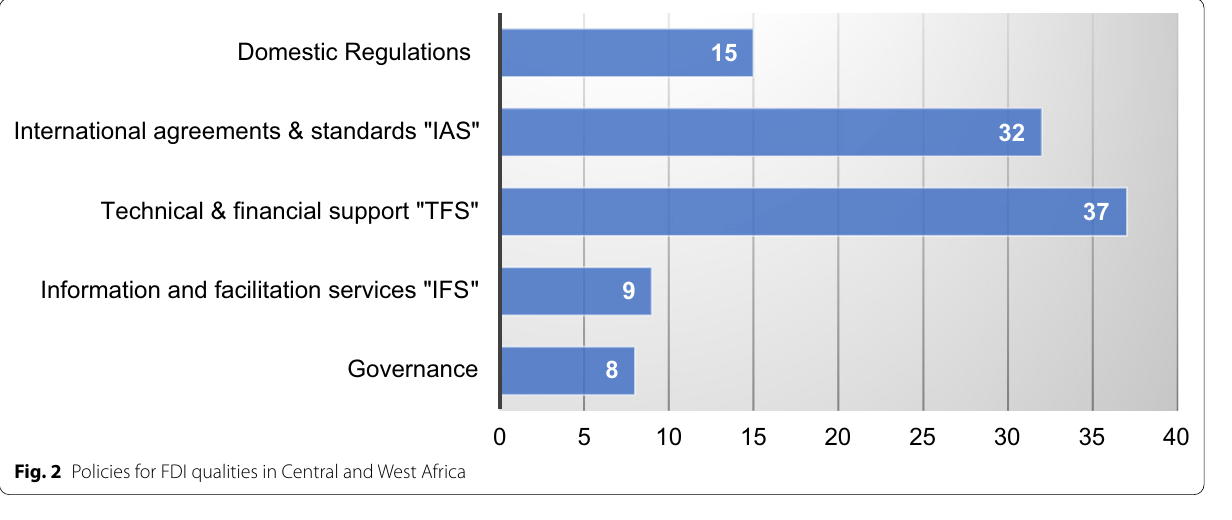
Fig. 2 Policies for FDI qualities in Central and West Africa